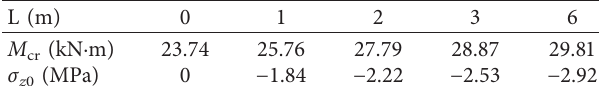
Figure 35: Stress history of the middle node on the top surface of the middle support. Table 11: Cracking loads and precompressive